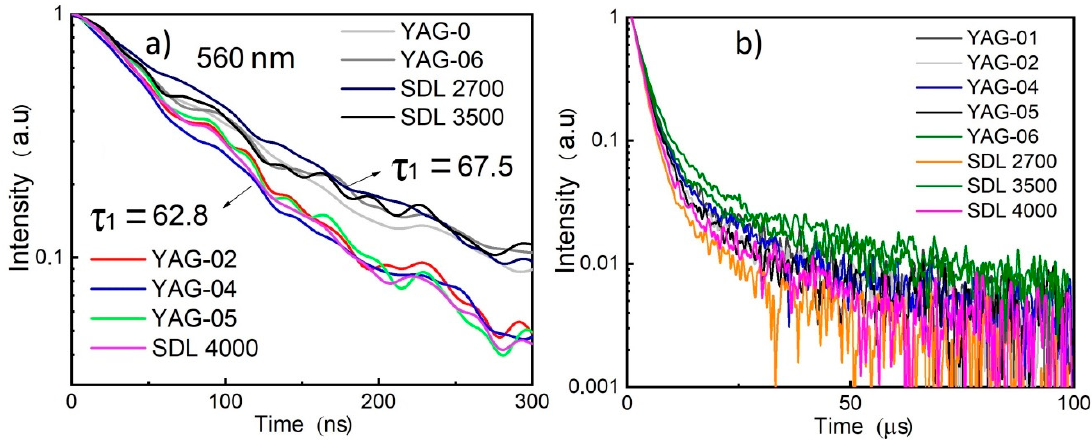
Figure 9. Kinetic curves of CL decay in the region of 560 nm in phosphors of different types; ( a ) in the range 0 − 300 ns; ( b ) in the range 0 − 100 μ s. Table 3. Decay time ( τ i ), amplitude (A i ), and light sum (A i × τ i ) of slow components of the kinetics of